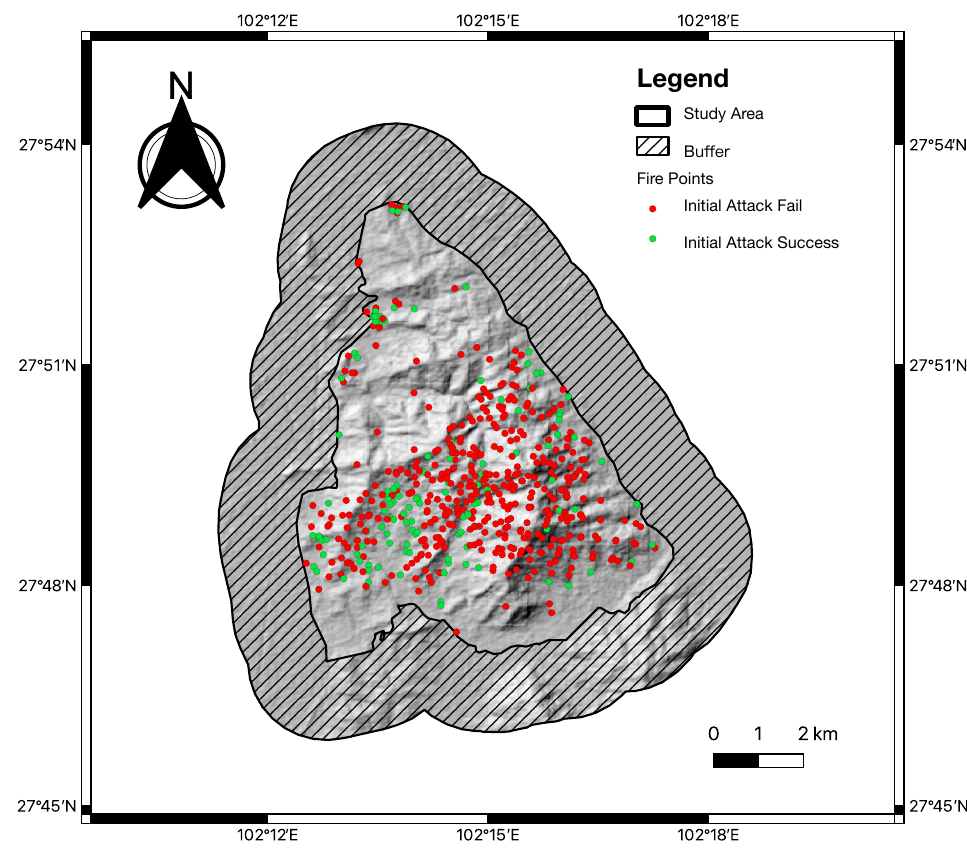
Figure 2. Ignition points